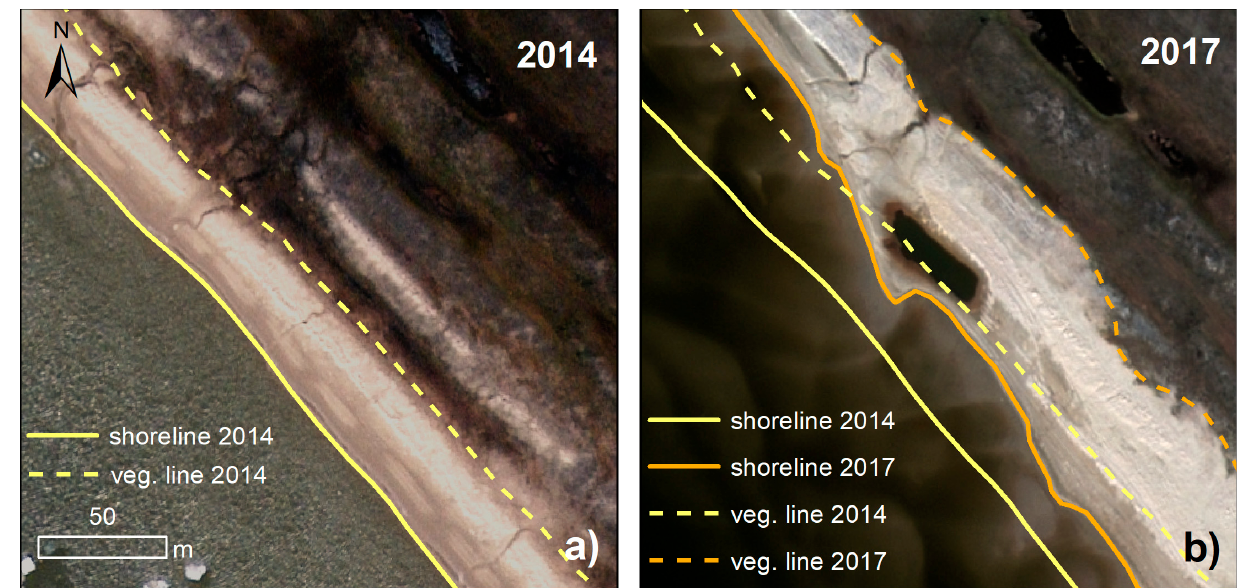
Figure 2. Coastal lines on the satellite images: ( a ) WV-2 2014 and ( b ) WV-2 2017.